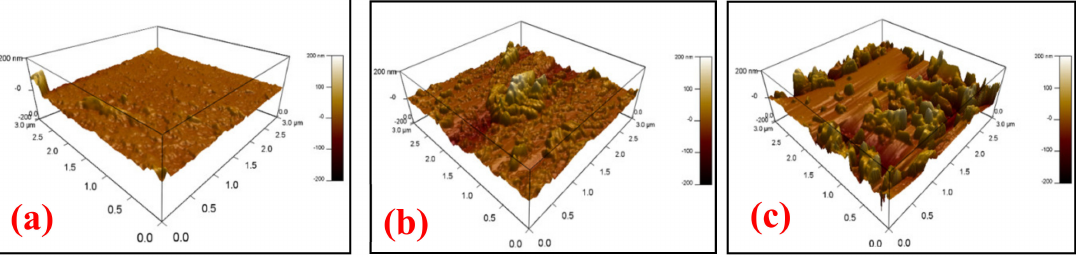
Figure 7. The atomic force microscopy AFM image of HNT-DMA-PPy@Ag nanocomposite film ( a ) 0.25 wt%, ( b ) 0.5, and ( c ) 1 wt% of